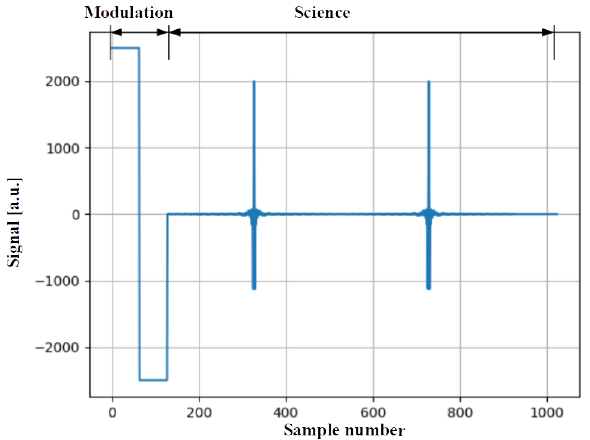
Figure 1. KISS data block recorded at 3.72Hz: frequency signal as a function of the sample number. There are a total of 1024 data samples: the first 128 are dedicated to the modulation and the remaining ones are to the forward and backward interferogram acquisition. The signal is the result of the median value subtraction (i.e., by scaling to 0Hz the median value), which represents the photometry, i.e., the signal integrated over the electromagnetic